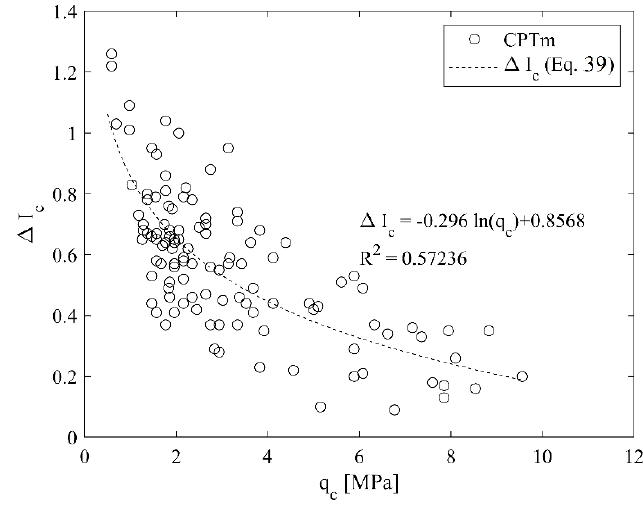
Figure 7. Soil classification from the CPTm results according to Schmertmann [56].